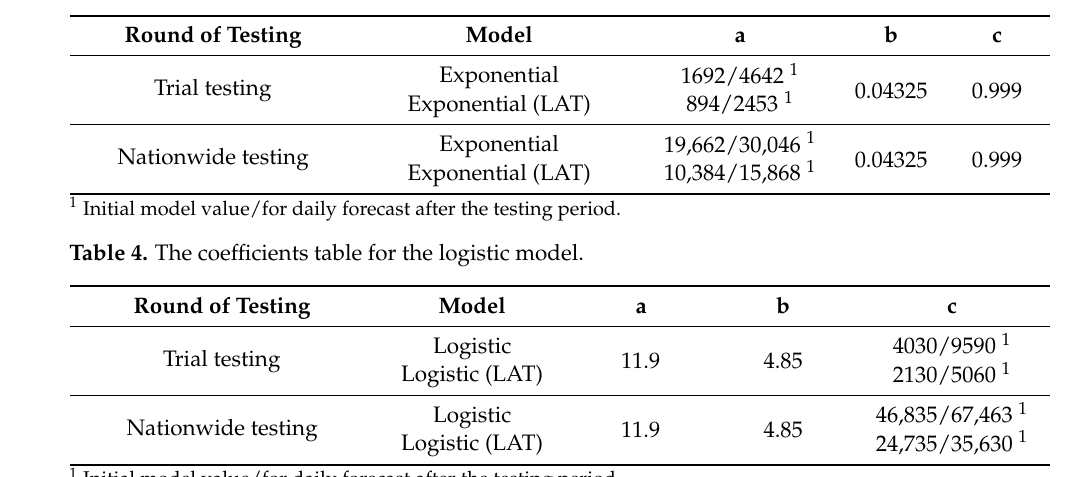
Table 3. The coefficients table for the exponential model.